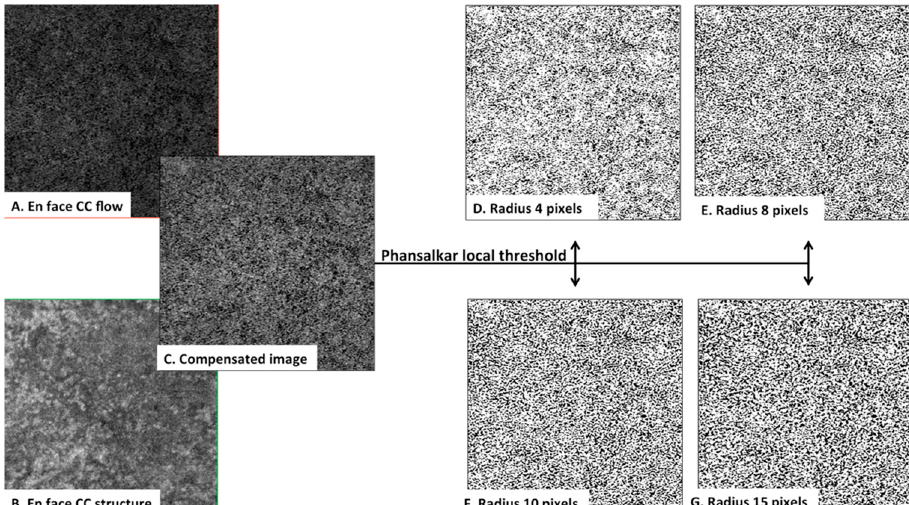
Figure 6. Phansalkar’s local thresholding method with window radii of 4, 8, 10, and 15 pixels on a 3 × 3 mm 2 swept source optical coherence tomography angiography (SS-OCTA) scan from an intermediate AMD eye. Flow choriocapillaris (CC) SS-OCTA image ( A ) and the en face CC structure slab ( B ) generated the compensated image ( C ). Panels ( D ) to ( G ) show the effect of choosing different window radii (( D ) radius 4 pixels, ( E ) radius 8 pixels, ( F ) radius 10 pixels, ( G ) radius 15 pixels)in Phansalkar’s local thresholding method for 3 × 3 mm SS-OCTA